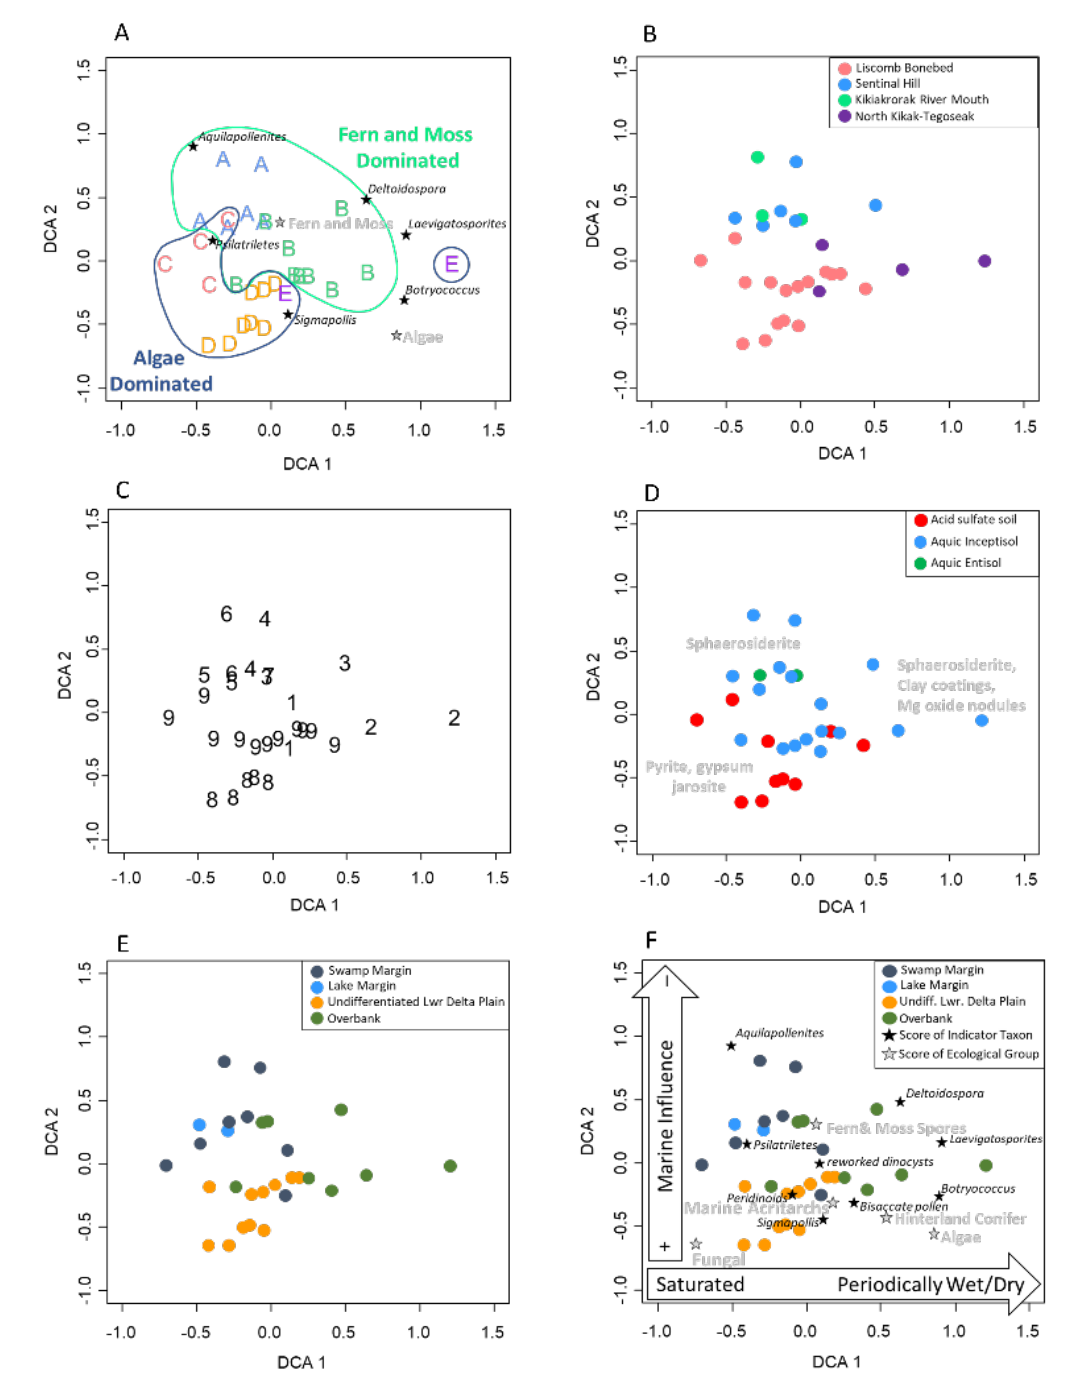
Figure 5. Ordination results with samples coded by: ( A ) Cluster; ( B ) locality; ( C ) paleosol horizon; ( D ) paleosol type; ( E , F ) environment. Select genus scores are overlain in ( A , F ) with black stars and text. Select ecological group scores are shown with grey stars and text. Select paleosol characteristics are labeled with grey text in ( D ).